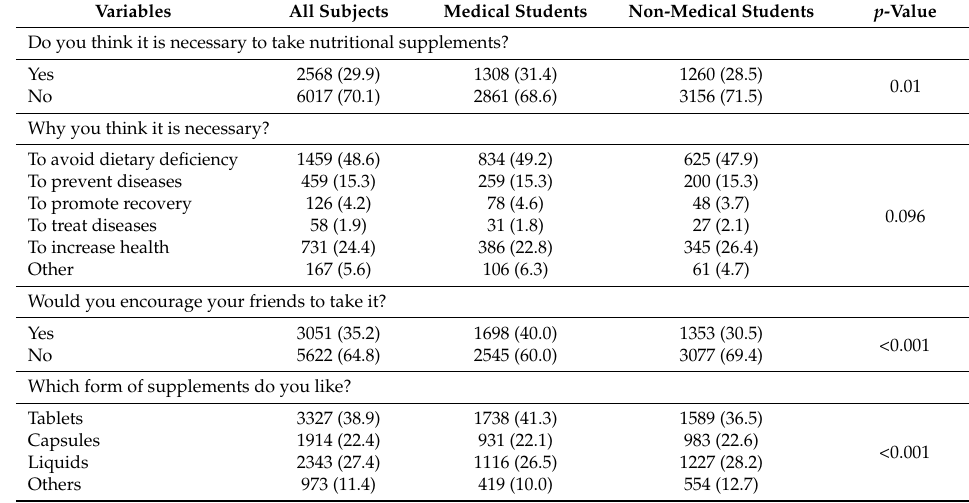
Table 5. Attitude towards nutritional supplements.